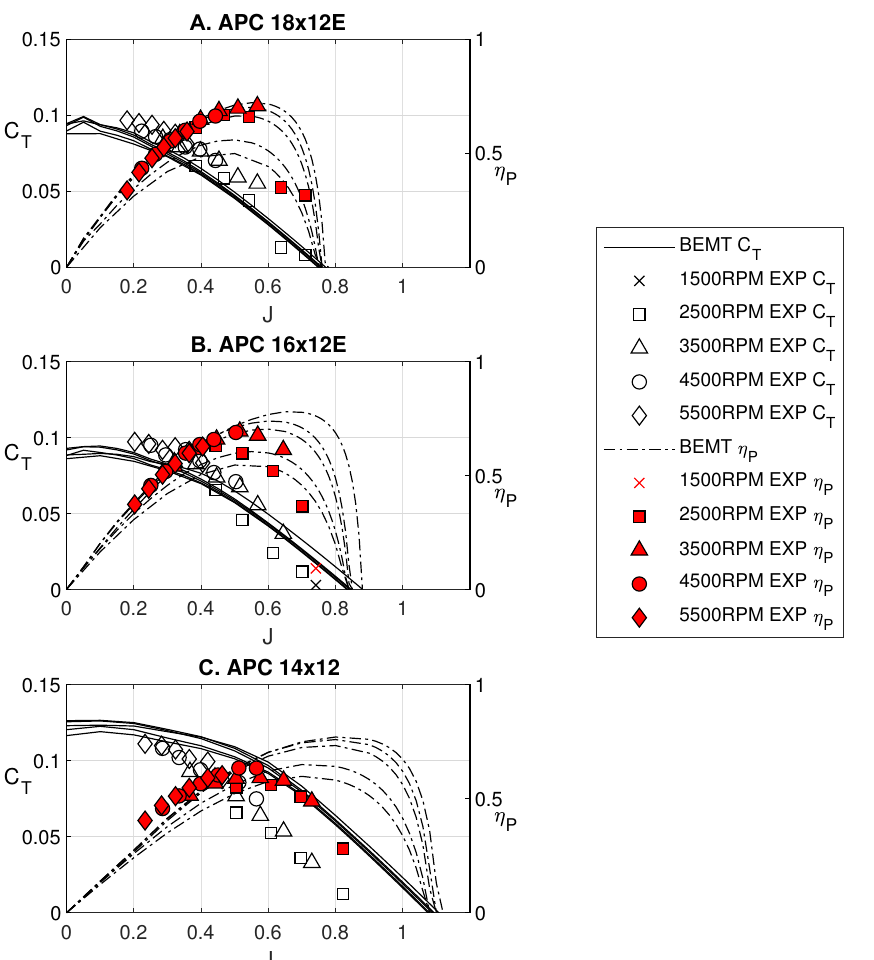
Figure 14. BEMT and experimental C T and η P for APC propellers 18 × 12E, 16 × 12, and 14 ×